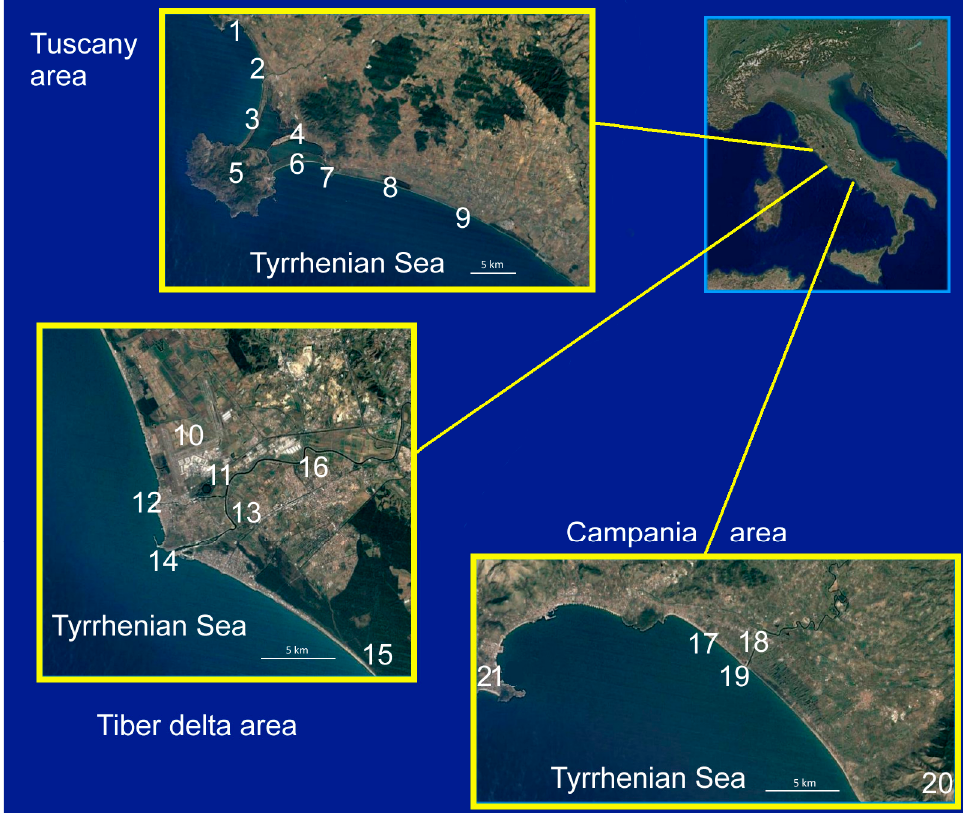
Figure 1. Location of the studied areas. Tuscany area : (1) Talamone; (2) Albegna River mouth; (3) Giannella Tombolo; (4) Orbetello; (5) Mt. Argentario; (6) Feniglia tombolo; (7) Ansedonia promontory; (8) Burano Lake; (9) Fosso Chiarone mouth. Tiber delta area : (10) Fiumicino airport; (11) Portus and Trajan Lake; (12) Minor Tiber River mouth; (13) Ostia ; (14) Main Tiber River mouth; (15) Laurentum ; (16) Ficana . Campania area : (17) Mt. d’Argento; (18) Minturnae ; (19) Garigliano River mouth; (20) Mt. Massico; (21) Gaeta. (Image Landsat/Copernicus-Google Earth).